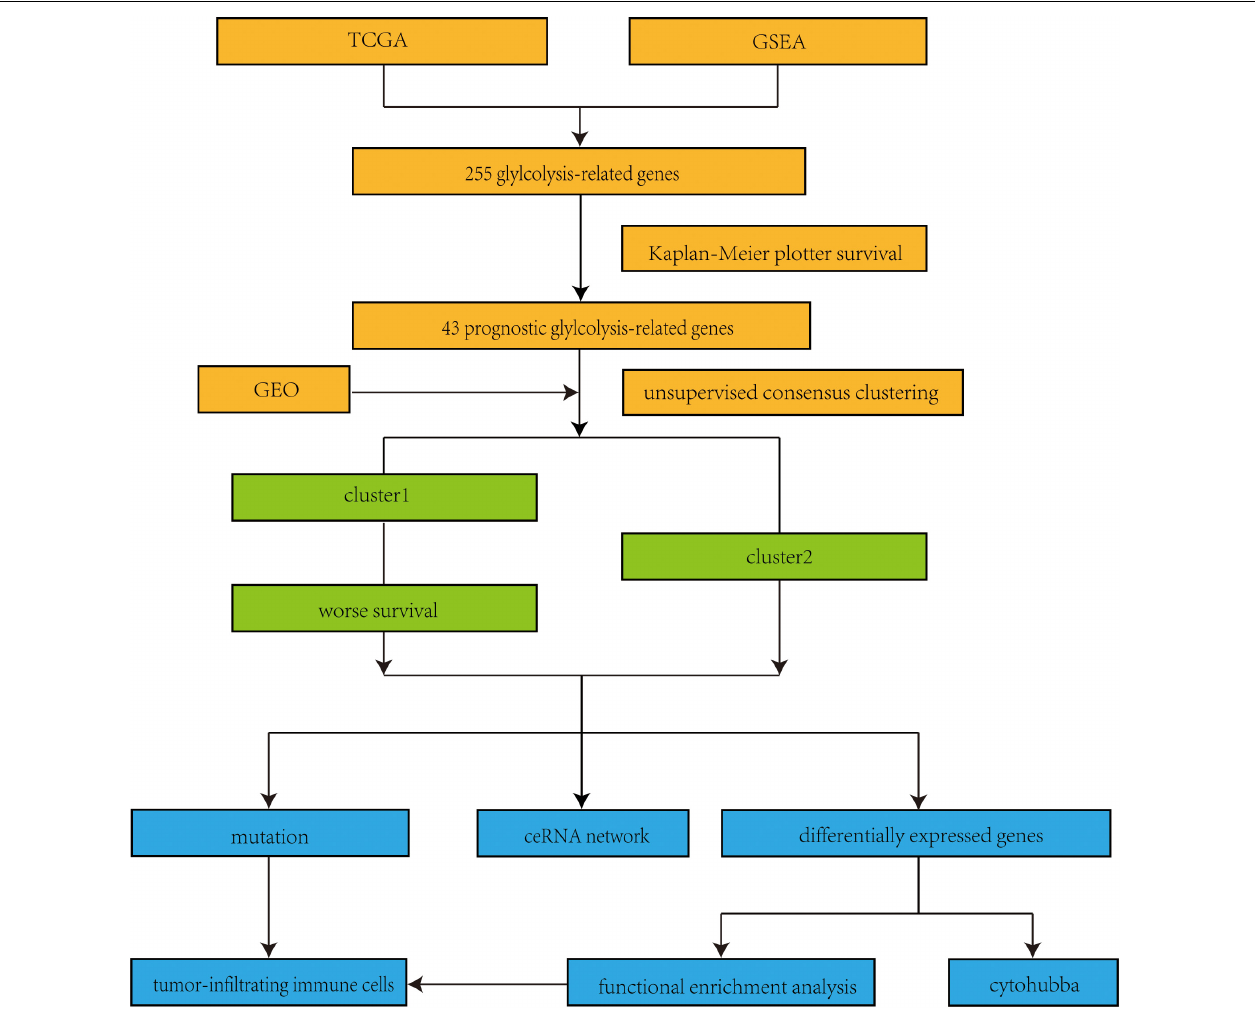
FIGURE 2 | Flow chart of this study. TCGA, the Cancer Genome Atlas; GSEA, Gene set enrichment analysis; GEO, Gene Expression Omnibus; ceRNA, competing endogenous RNA.